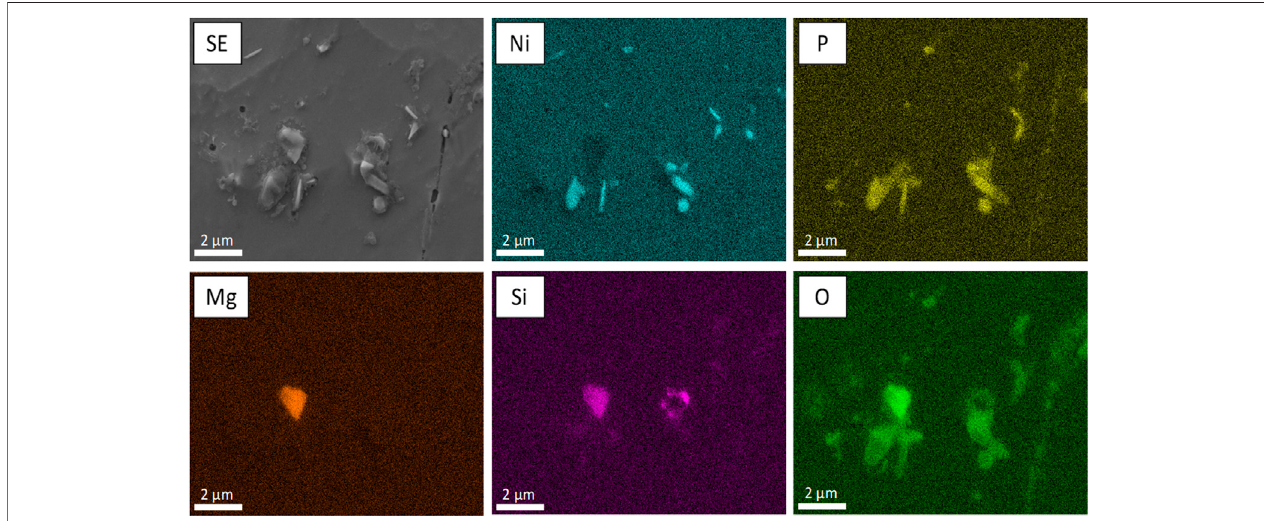
FIGURE 4 | Correlative Raman-SEM-EDX analysis of a Fe – Ni – P inclusion. (A) SE-image and EDXS-mapping of the whole inclusion. (B) Raman point measurements of the matrix materials and the oxygen rich veins.